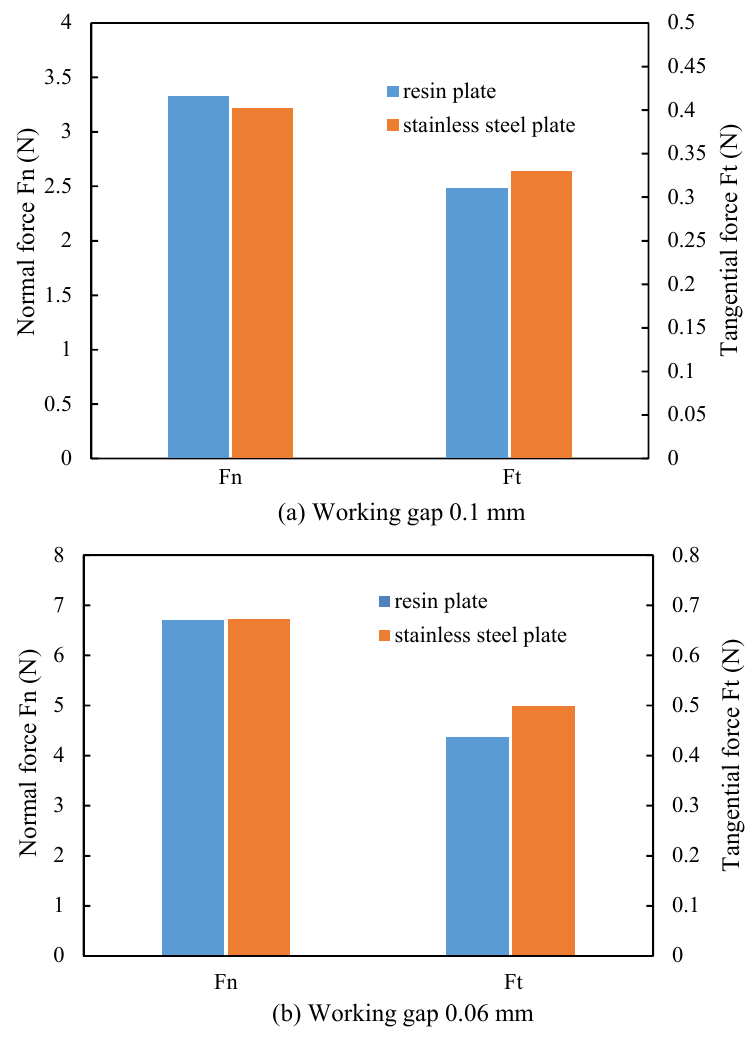
Figure 10. Measured finishing force.